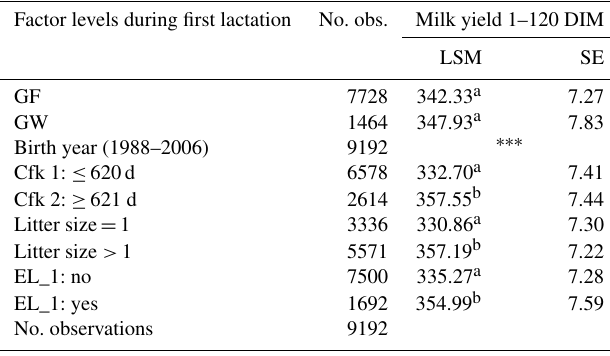
Table 5. LSM values during the first 120d of the first lactation in dairy goats. Factor levels during first lactation No.